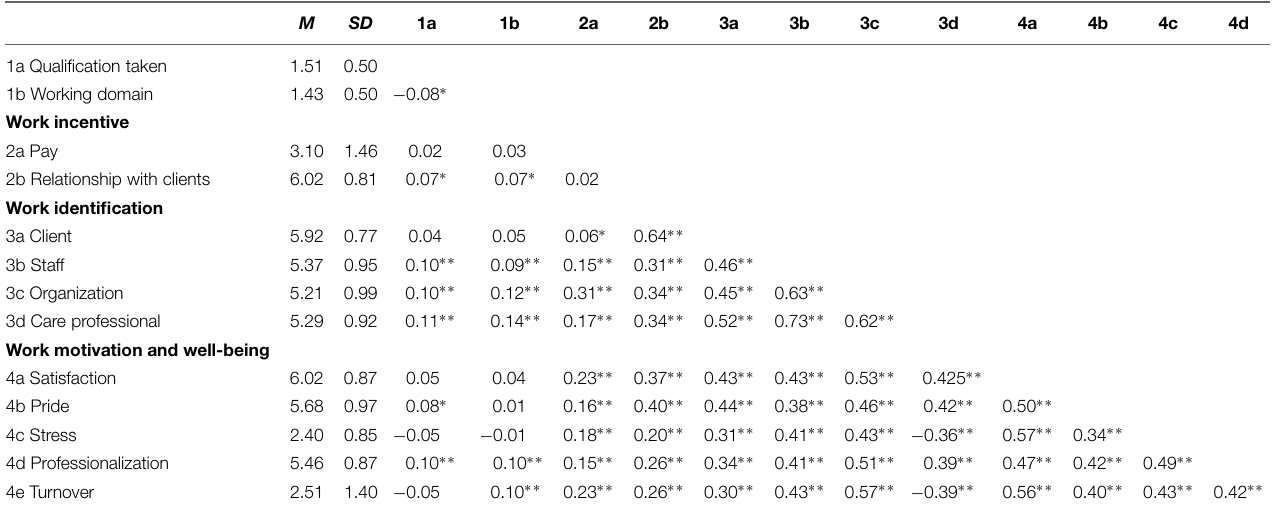
TABLE 2 | Bivariate correlation, Time